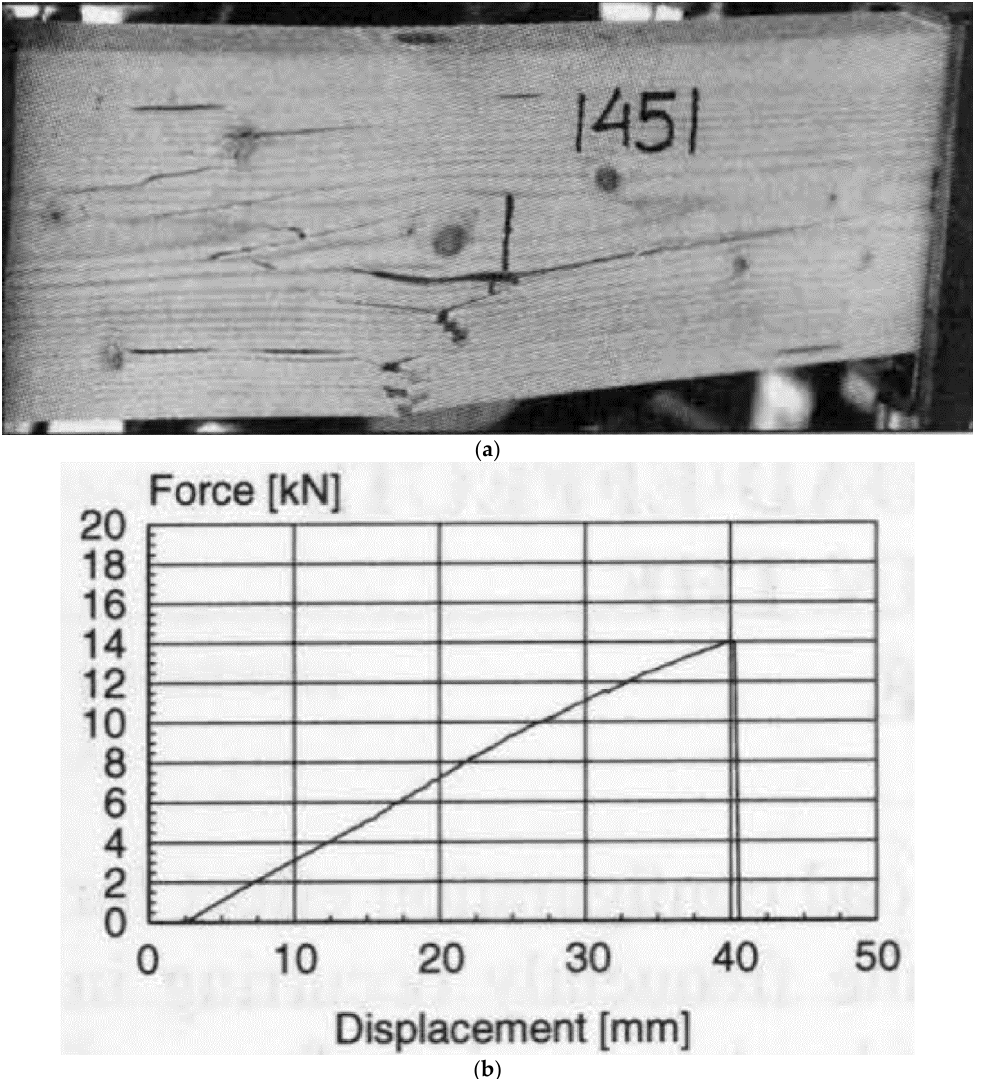
Figure 39. ( a ) Photograph of failed wood specimen that had been subjected to a bending load. ( b ) The load–displacement graph for the specimen shown in ( a ). The graph shows that no plastic deformation occurred before failure, i.e., the failure was brittle. From [100].